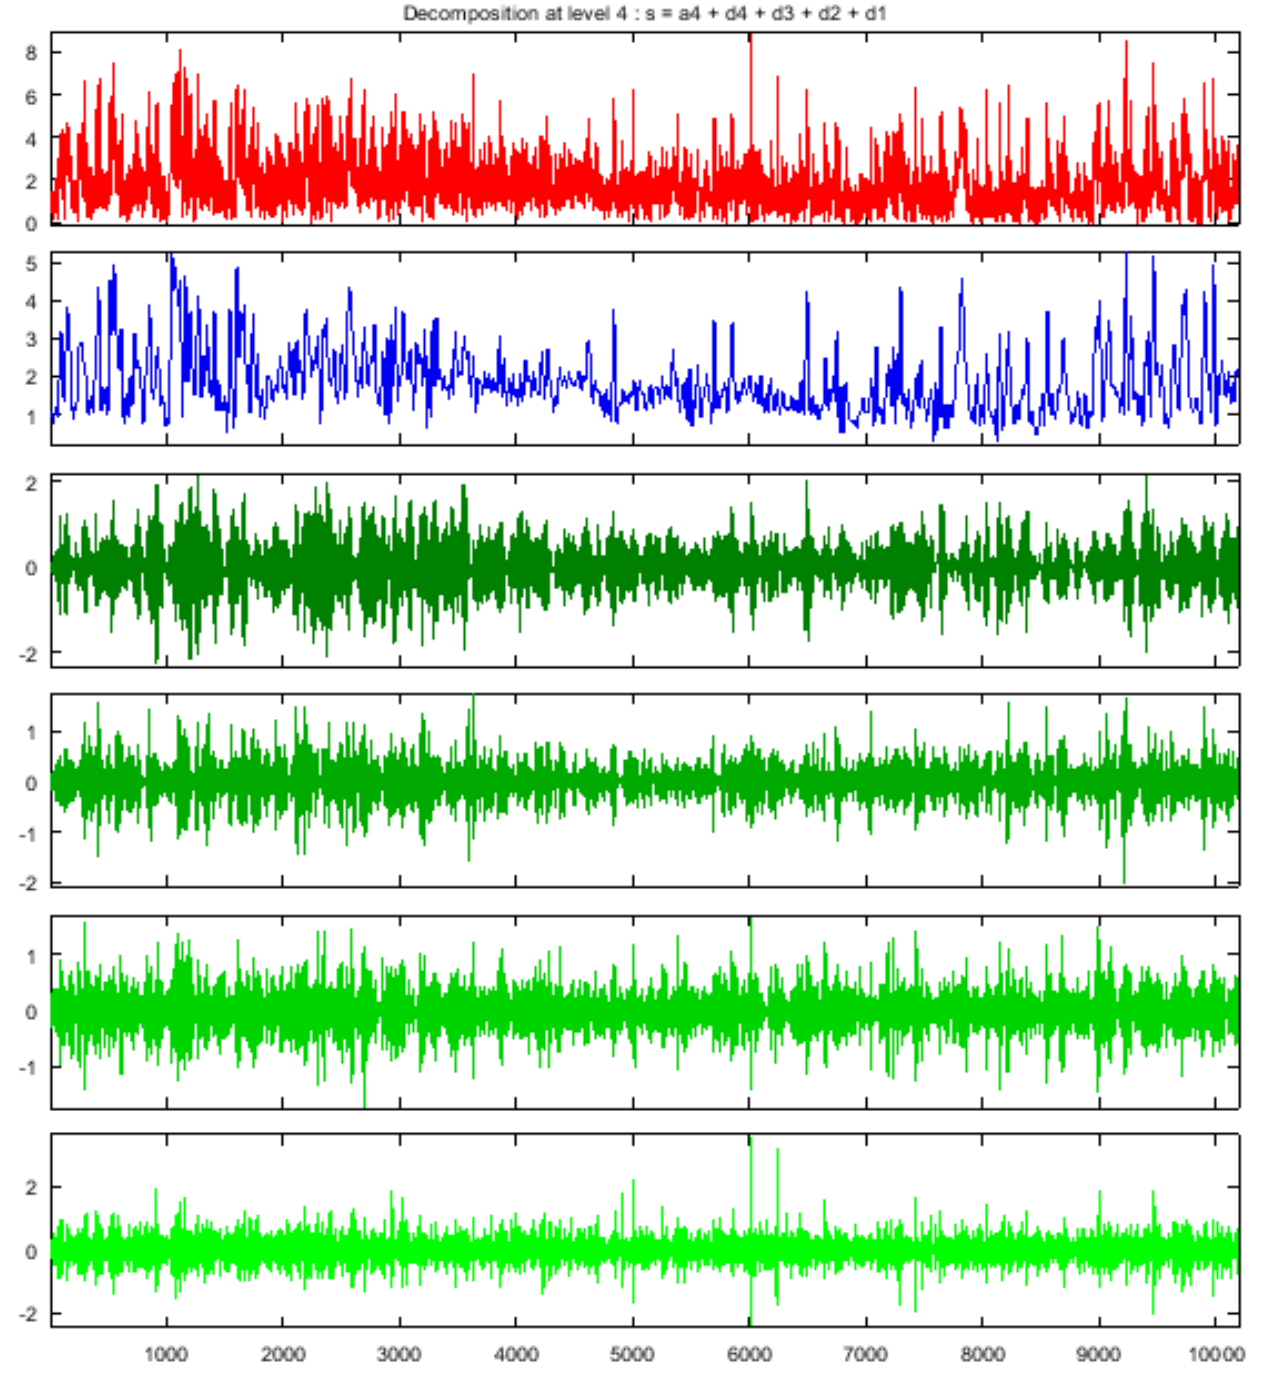
Figure 10. Decomposition of WSPM hourly data. The X-axis is hours, and the first part in each decomposed feature is a 4, d 4, d 3, d 2, d 1, from top to bottom,